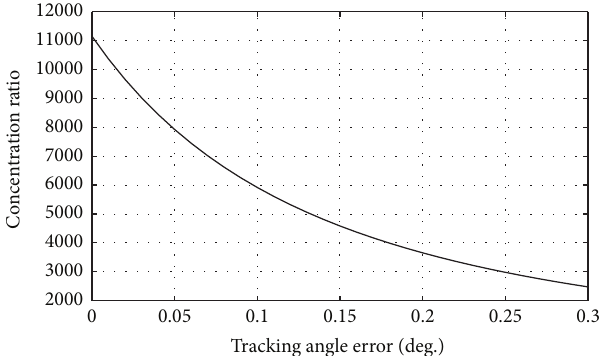
Figure 5: Variation of geometrical concentration of a parabolic dish with respect to errors for 45 ∘ rim